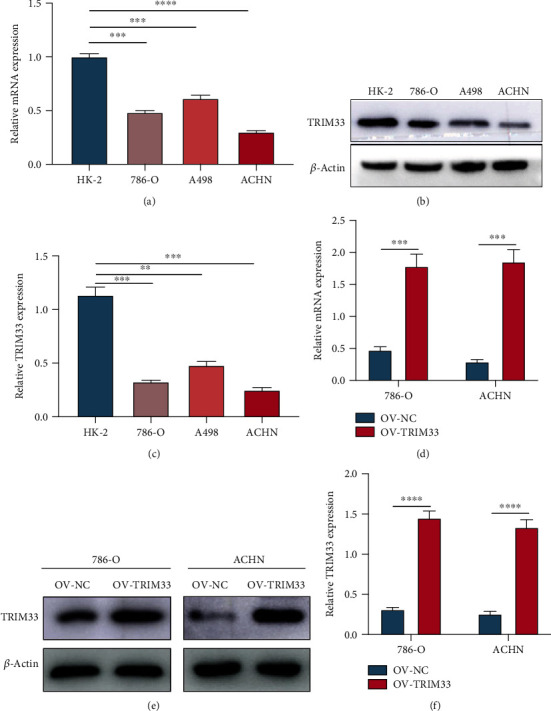
The expression of TRIM33 in HK-2, 786-O, A498, and ACHN cell lines and verification of the overexpression effect. (a) Quantitative real-time PCR was used to detect the expression of TRIM33 in HK-2, 786-O, A498, and ACHN cell lines. (b and c) Western blot analysis of the expression of TRIM33 in HK-2, 786-O, A498, and ACHN cell lines and data analysis. (d) Quantitative real-time PCR was used to verify TRIM33 overexpression in two kidney cancer cell lines. (e and f) Western blot analysis confirming TRIM33 overexpression in two kidney cancer cell lines and data analysis. ∗∗P < 0.01; ∗∗∗P < 0.001; ∗∗∗∗P < 0.0001.